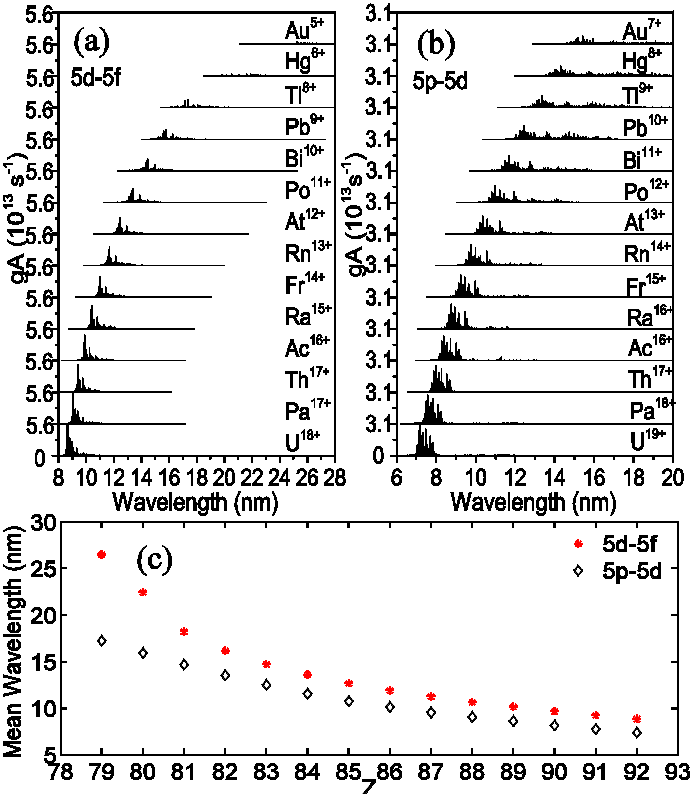
Figure 6. (Color online) Summed peak emission from ( a ) 5d − 5f and ( b ) 5p − 5d UTAs including CI in elements with Z = 79 – 92 . ( c ) Dependence of UTA transition energies on atomic number Z , 5d − 5f (red stars) and 5p − 5d (black diamonds).